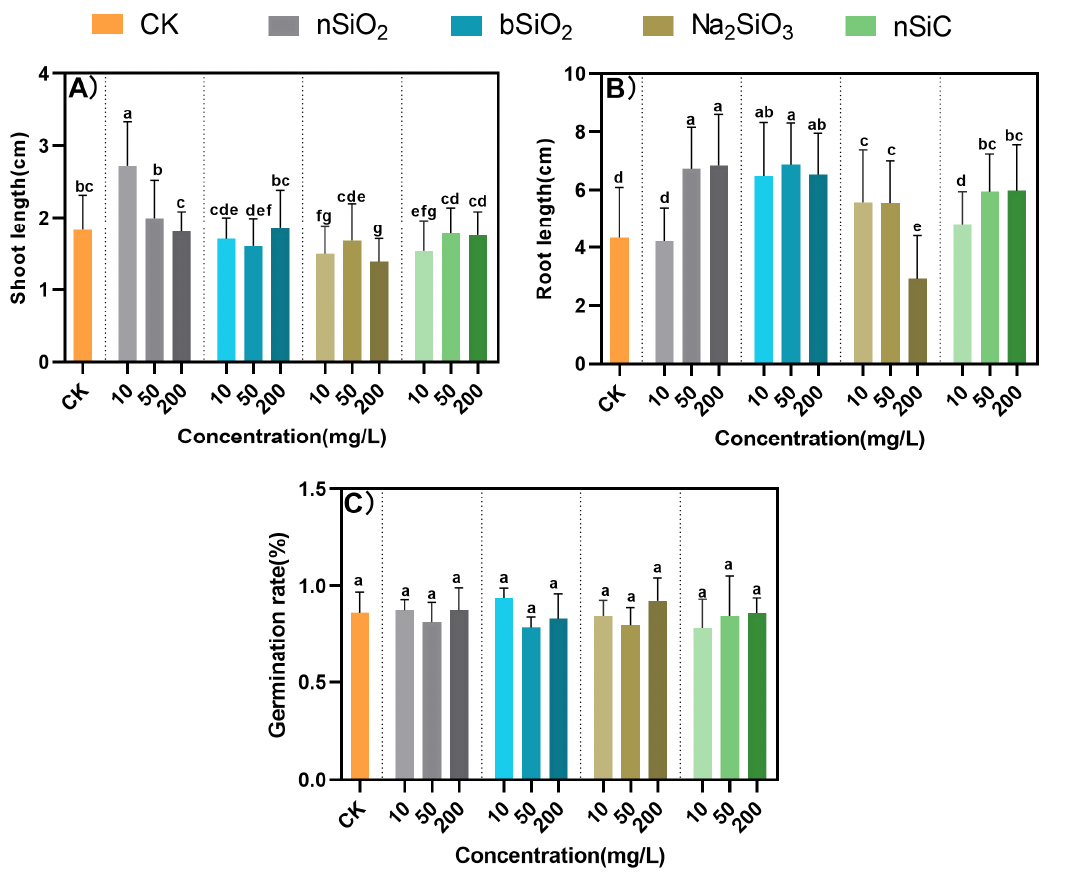
Figure 1. Effects of Si-based NMs on rice seed germination. ( A ) Seed sprout length; ( B ) Seed root length; ( C ) Seed germination rate. Columns marked with the same letter were not significantly different at p < 0.05 ( n = 4).